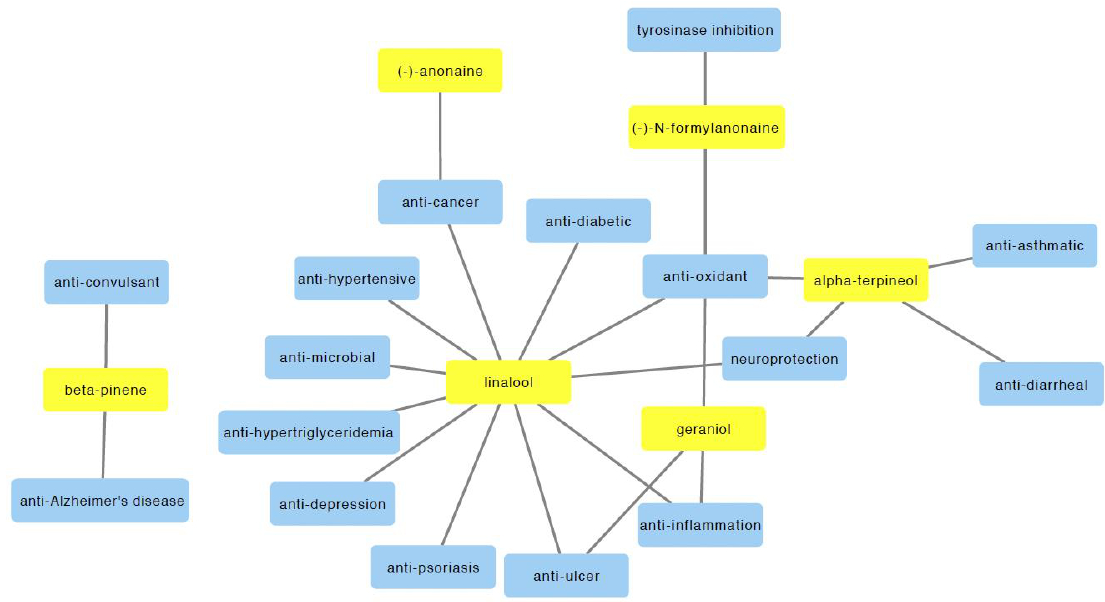
Figure 3. A summary of bioactivities of selected bioactive compounds in M. alba.